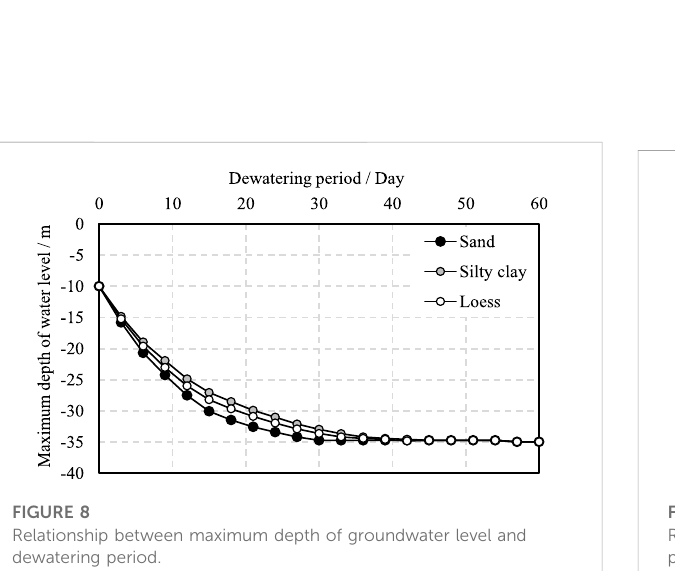
FIGURE 8 Relationship between maximum depth of groundwater level and dewatering period.